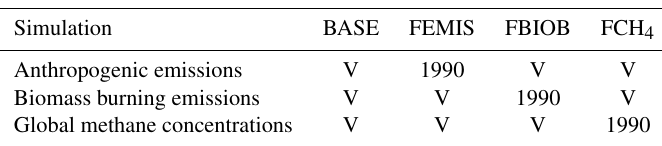
Figure 1. Spatial distributions of bimonthly mean (a) surface temperature, (b) 850hPa specific humidity, (c) cloud cover, (d) anthropogenic NO emissions, and (e) biomass burning CO emissions averaged for 2006–2010. Table 2. Configuration of the GEOS-Chem simulations. “V” indicates that specific inputs vary interannually in the simulation, and “1990” denotes that the inputs are fixed to 1990